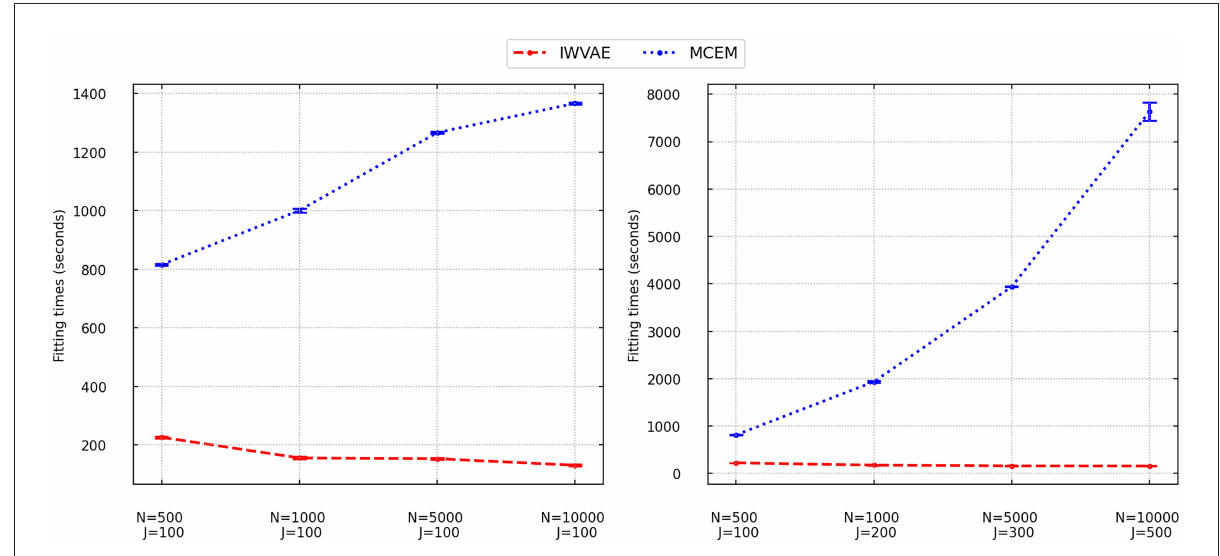
FIGURE1 Fitting times for IWVAE and MCEM with M3PL model under the single (different sample sizes N and fixed item dimension J ) and double [different ( N , J )] asymptotic regimes. Vertical bar areas mark empirical 95%